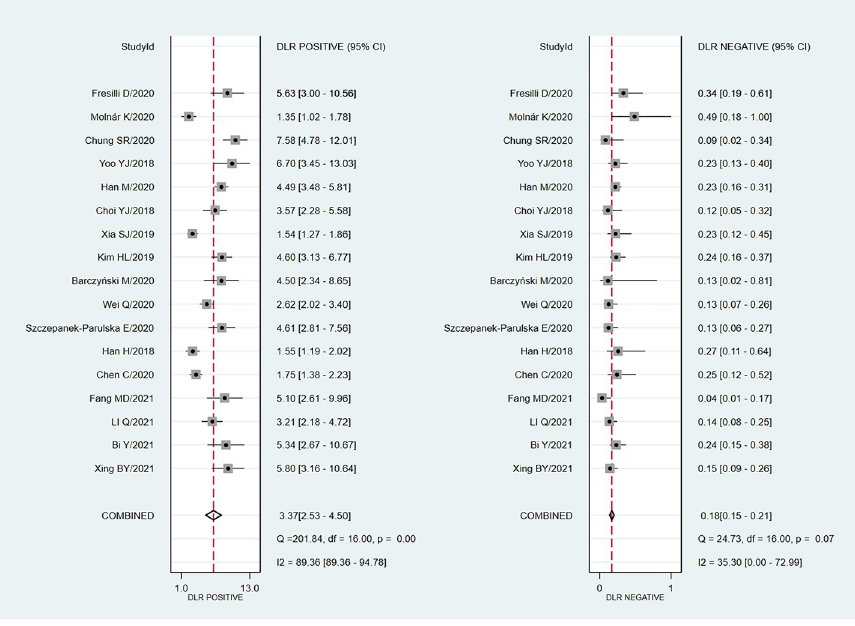
Fig 4. The forest diagram results of the likelihood ratio between negative and positive of S-Detect diagnosis obtained in this paper.